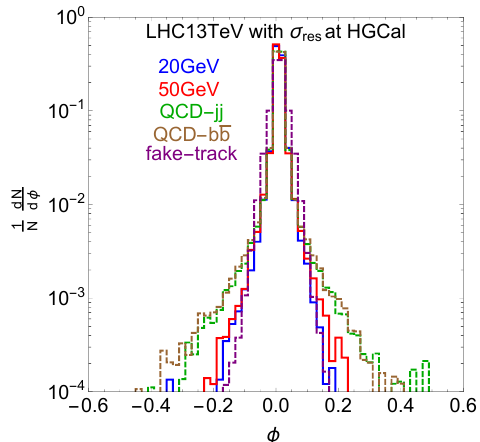
Figure 9 . The distribution of ∆ φ for the tracks in the DV fitting procedure, where ∆ φ is the azimuthal angle change when moving from the reference point to the fitted DV.